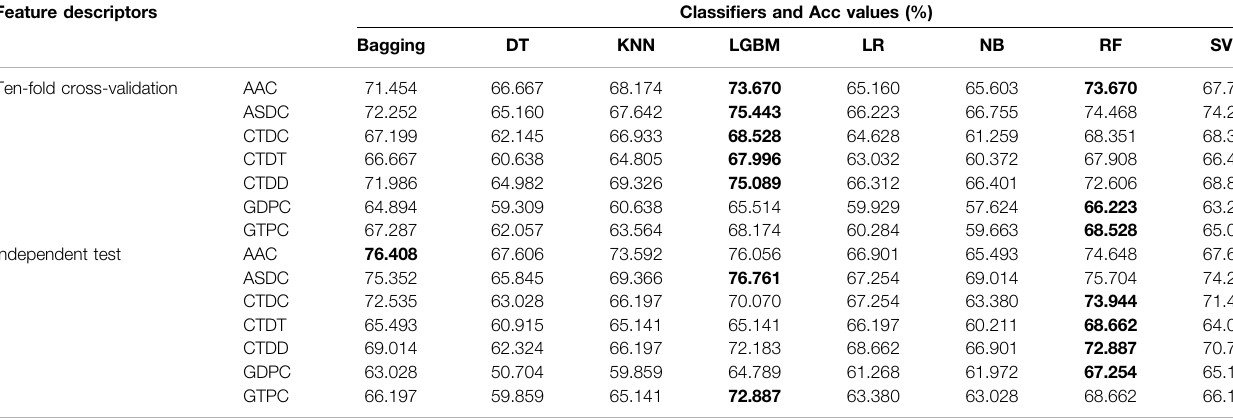
TABLE 1 | The accuracy (Acc) results of a single feature descriptor classi fi ed by different machine learning algorithms. Feature descriptors